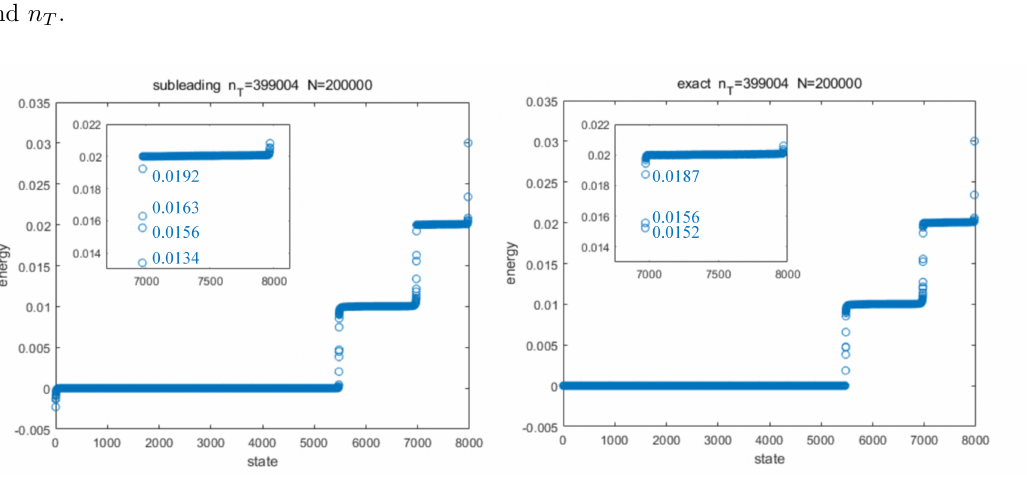
Figure 4 . The spectra are calculated in the system with n T = 399004 and N = 200000 . The first plot is the spectrum of action with subleading corrections, while the second one is that of exact action. New energies caused by subleading corrections are 0.0134 and 0.0192, as 0.0156 and 0.0163 can also be found in the spectrum of leading action shown in figure 3, including acceptable errors.